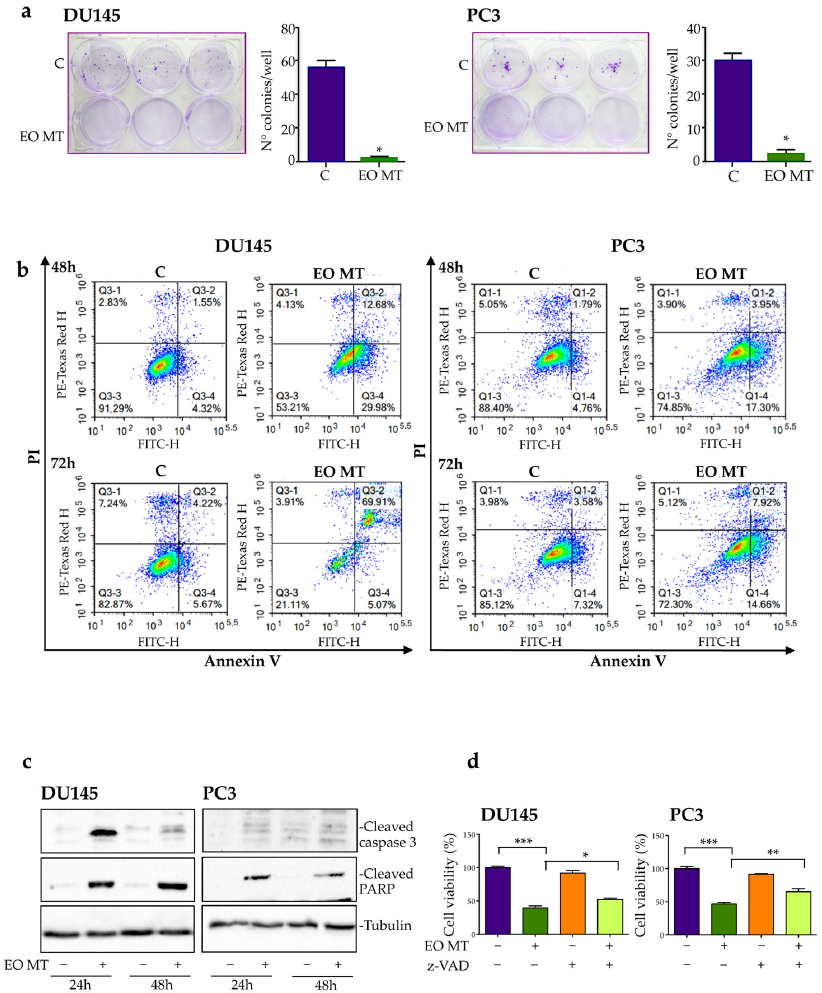
Figure 3. Effect of Myrtus communis subsp. tarentina (L.) Nyman (EO MT) on clonogenic capacity of DU145 and PC3 cells and apoptosis involvement in its cytotoxic activity. For clonogenic assay ( a ), both cell lines were treated with EO MT (400 µ g/mL) for 48 h, and the colony-forming ability was assessed after 12 days of culture. Cell colonies were fixed with methanol stained with crystal violet. Data were expressed as the number of colonies of treated DU145 and PC3 cells in comparison with the no treatment control group (C). Data represent mean values ± SEM and were analyzed by a Student’s t test. * p < 0.05 vs. C. For flow cytometry analysis ( b ), DU145 and PC3 cells treated with EO MT (400 µ g/mL) for 48 h or 72 h were stained with Annexin V/PI and analyzed by Novocyte 3000. In each square, the top-left box represents necrotic cells, the top-right box represents cells in late apoptosis, the bottom-left box represents viable cells, and the bottom-right box represents cells in early apoptosis. A Western blot analysis of apoptosis-related proteins was carried out on control (C) and EO MT (400 µ g/mL)-treated cells for 24 h and 48 h ( c ). Tubulin antibody was used as a